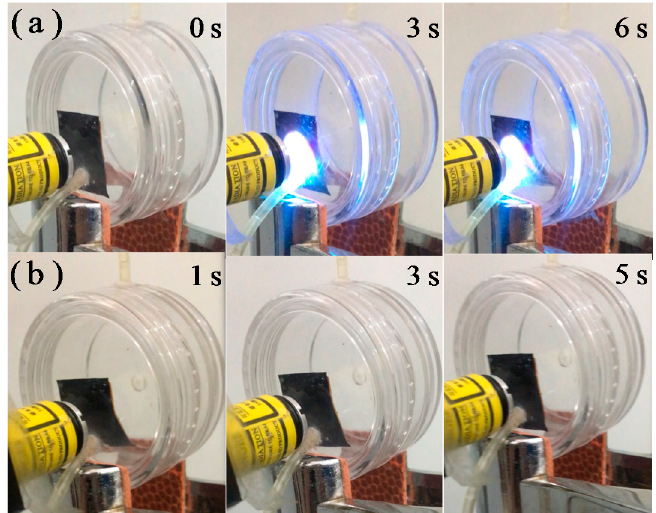
Figure 6. ( a ) A Photograph of experimental setup of the conceptual device of microfluidic system. A CF20 with the size of 12 mm × 6 mm × 20 µm was used as the microvalve actuator; ( b ) A Scheme of the PMMA valve chamber with the AZO-CLCP/CNT nanocomposite microvalve actuator set in it without the UV irradiation; ( c ) A Schematic illustration of the switching on process of the microvalve under irradiation of UV light.